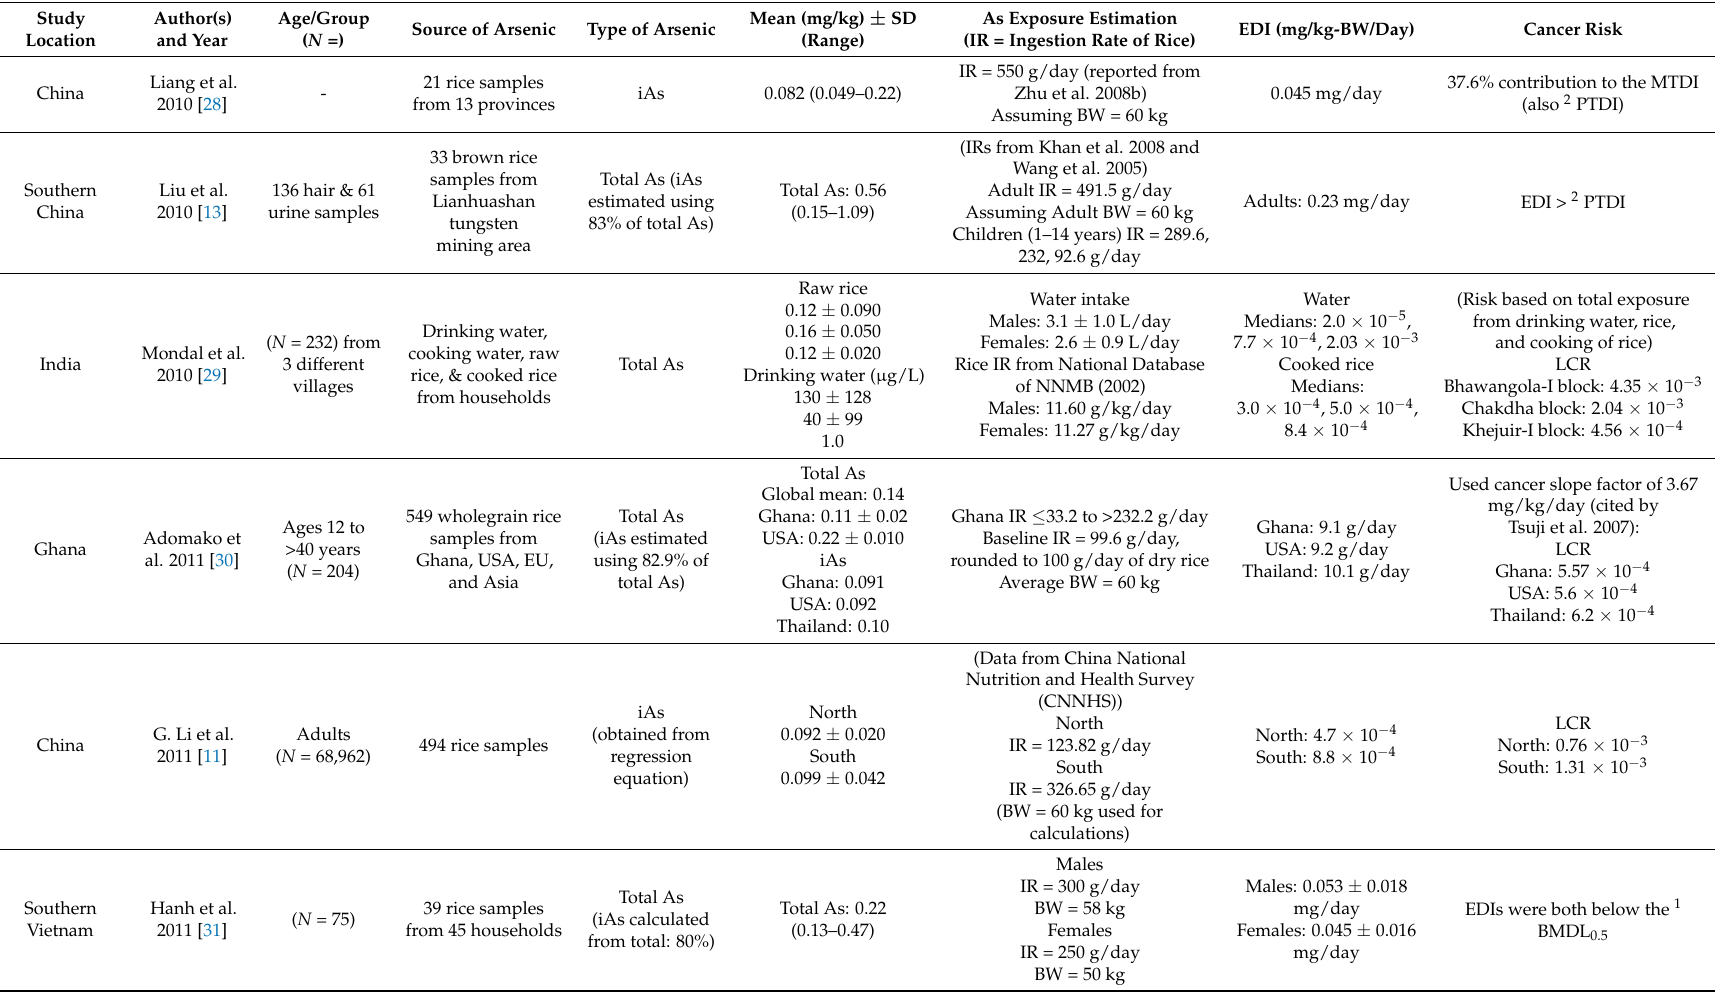
Table 2. Summary of arsenic exposure levels and arsenic-related cancer risk